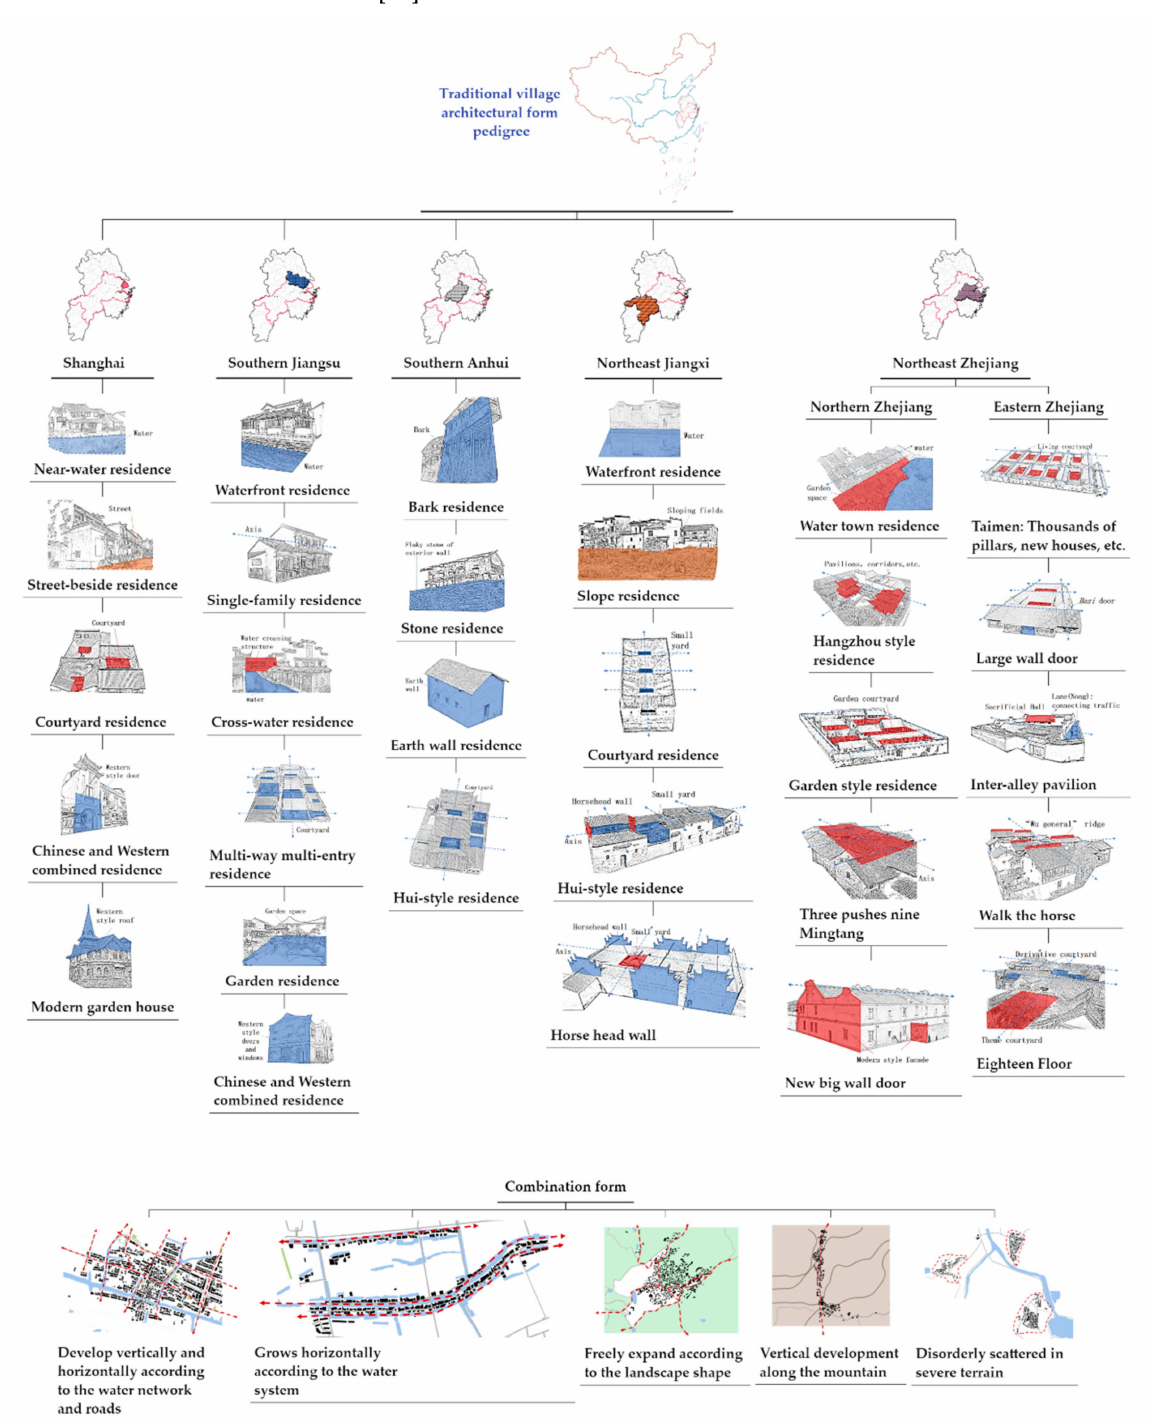
Figure 10. Traditional village architectural form pedigree structure: edited by